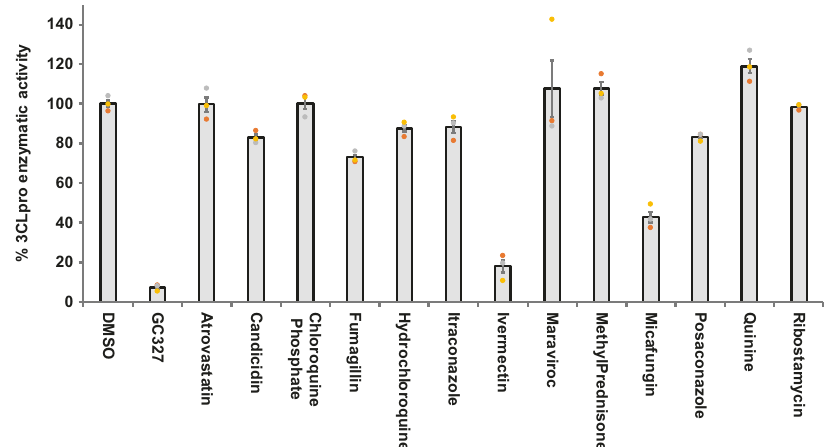
Fig. 4 Ivermectin exhibited complete inhibition of SARS-CoV-2 3CLpro enzymatic activity whereas micafungin partially inhibited the enzyme. The off- target drugs that are being used to treat non-viral ailments selected by in silico studies were screened for their inhibitory activity against SARS-CoV-2 3CLpro enzyme as described under Methods section. The percent enzymatic activity was calculated as described in Fig. 1 legend. Blank values were subtracted from all the readings before calculating the percent activity. Representative of three individual experiments with triplicate values were presented graphically ( n = 3). P value < 0.001 considered as statistically signi fi cant. One-way ANOVA with Dunnett ’ s Multiple Comparison post-hoc test used to calculate the statistical signi fi cance.